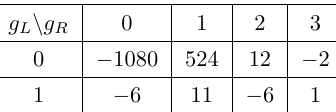
for the homology class β = ( d β